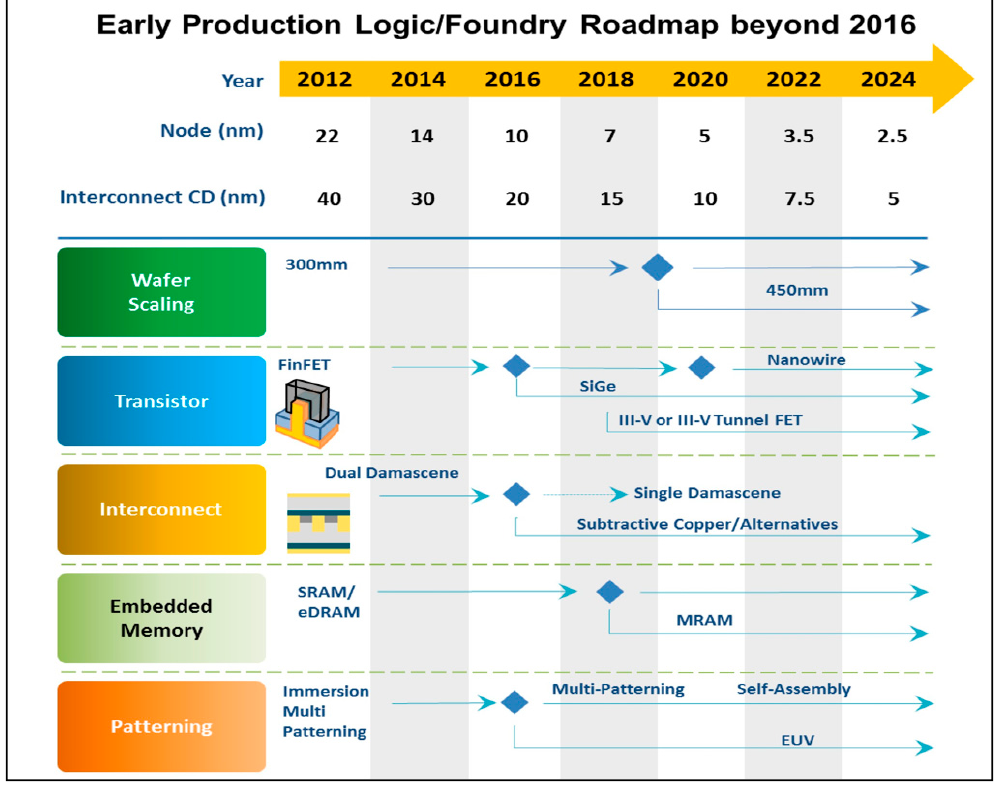
Figure 27. Logic technology roadmap and alternatives for key components with timing for critical decision points.